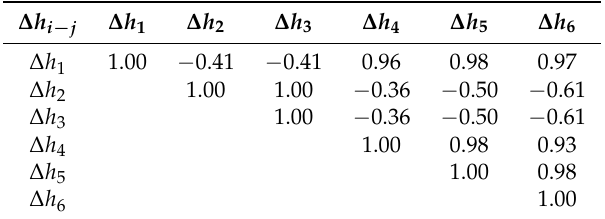
Table 3. Correlation matrix of w -test statistics for levelling network ( b